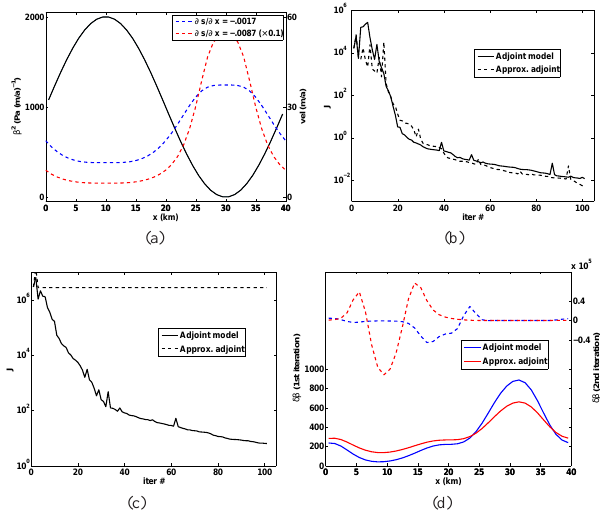
Fig. 3. (a) Data for inverse problem. ”True” basal sliding coefficient β 2 true (left axis) and corresponding velocity profiles (right axis)for low and high surface slopes. (b) Cost function J versus number of model evaluations for full and approximate adjoint, low surface slope. (c) Same for high surface slope. (d) Gradient found by full and approximate adjoint in first iteration (solid) and second iteration (dashed), high surface slope.